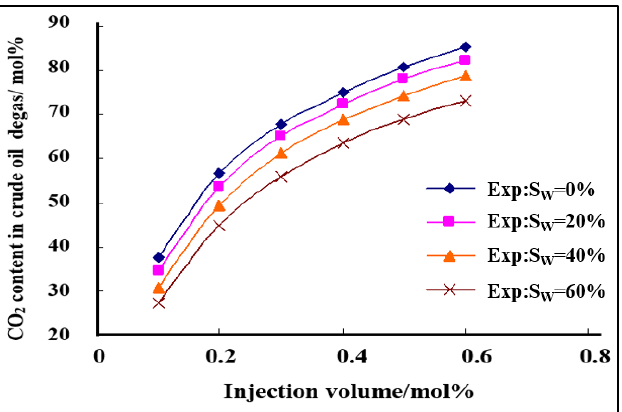
Figure 15. Relationship between gas–oil ratio and CO 2 injection molar quantity under different water content.